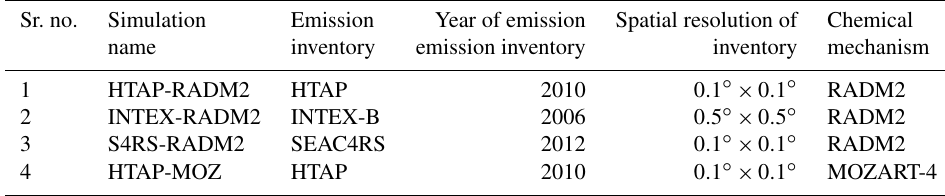
Table 3. A brief description of the different WRF-Chem simulations conducted. “Sr. no.” indicates the serial number. Sr. no.